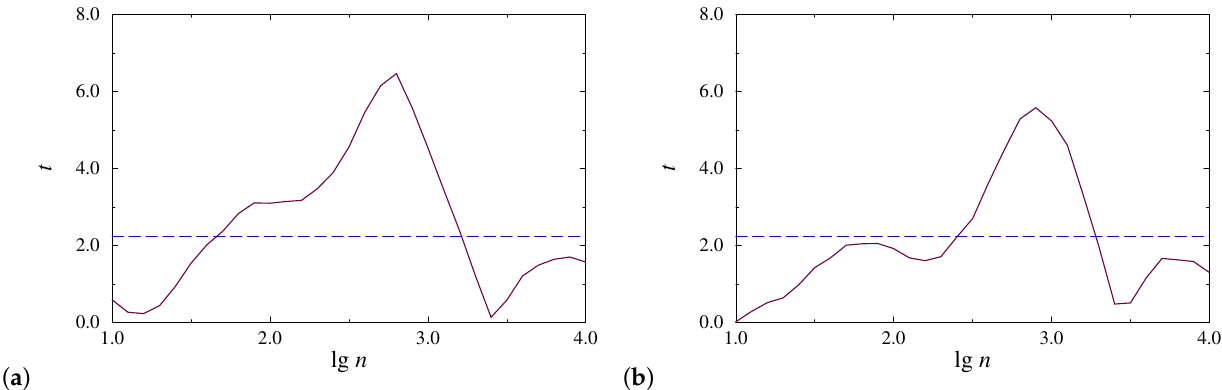
Figure 2. Examples of computations of local scaling exponents on a plane (time, range of scales) for injection ( a ) and inhalation ( b ) anesthesia. The arrows indicate when the anesthesia injection or inhalation started.